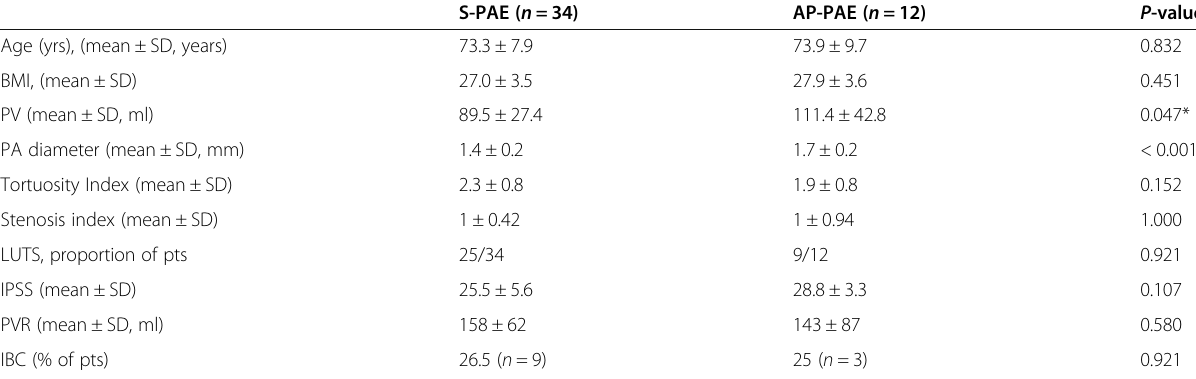
Table 1 Baseline demographic, anatomic and clinical data for the two patient groups of this